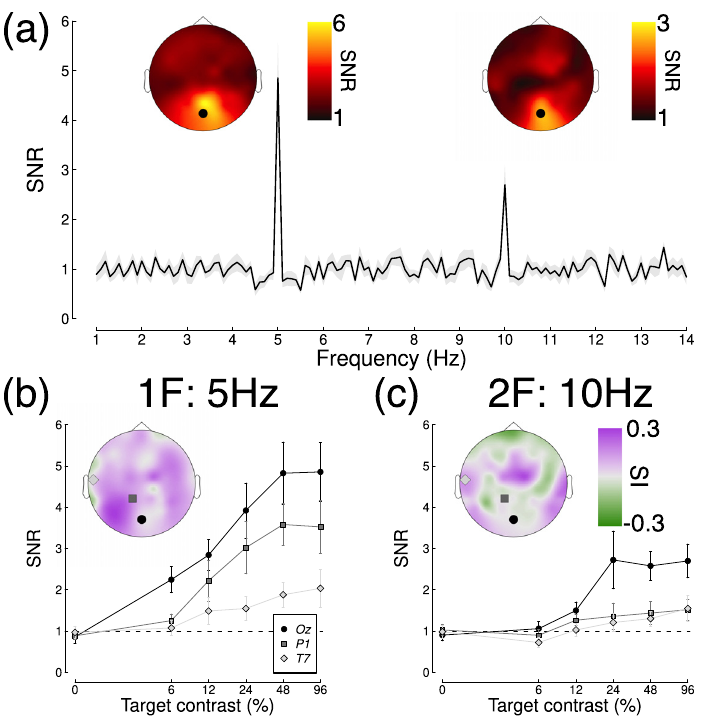
Fig 3. Averaged Fourier spectrum and example contrast response functions. Panel A shows the spectrum for a high contrast target, with inset scalp plots showing SNRs at the first and second harmonic frequencies. The spectrum is taken from electrode Oz , indicated by the black points in the scalp plots. The shaded region and error bars indicate ± 1 standard error. Panels B and C show example contrast response functions at the first and second harmonics at electrodes Oz , P1 and T7 , averaged across participants (N = 12). The inset scalp plots show how the saturation index varies across the